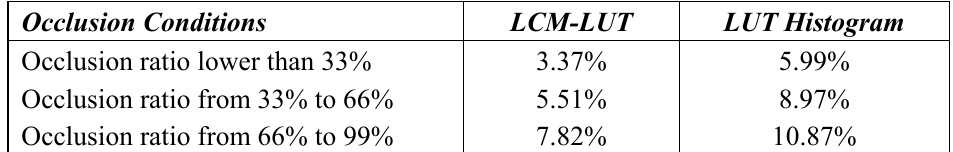
Table 5. Average noisy pixels in the segmented image for different